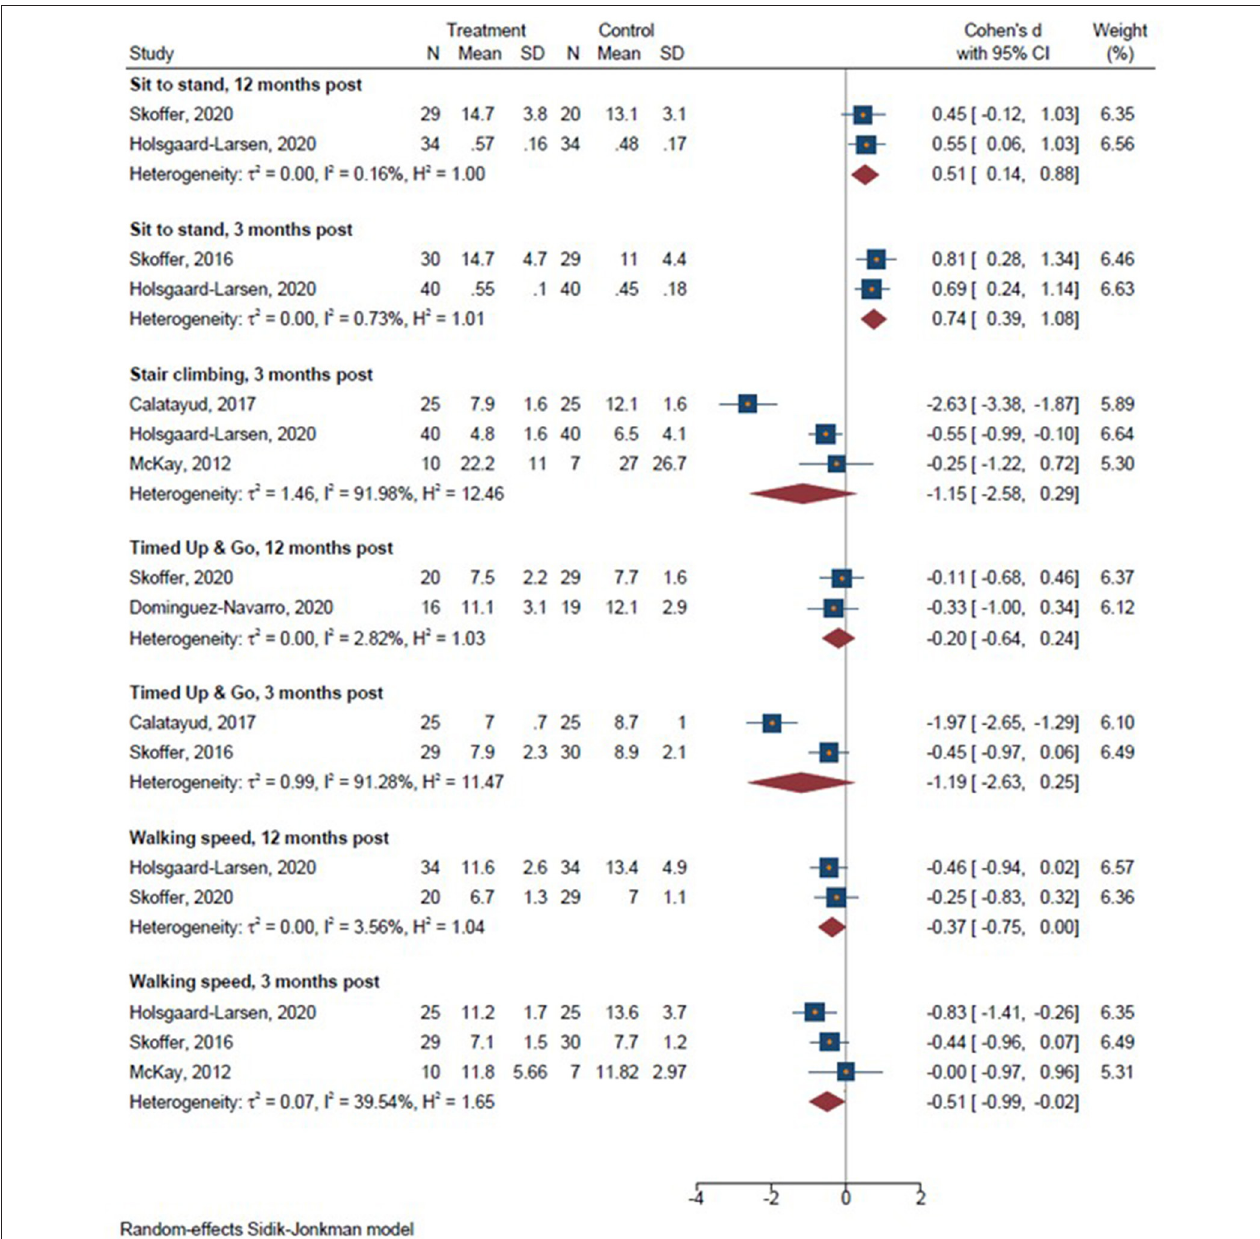
FIGURE 3 | Forrest plots on post-operative functional performance 3 and 12 months post-operatively. Forest plots of the results of a random-effects meta-analysis shown as standardized mean differences with 95% CIs on functional performance 3 and 12 months post-operatively. For each study, the blue square represents the point estimate of the intervention effect. The horizontal line joins the lower and upper limits of the 95% CI of this effect. The red diamonds represent the pooled mean difference for each